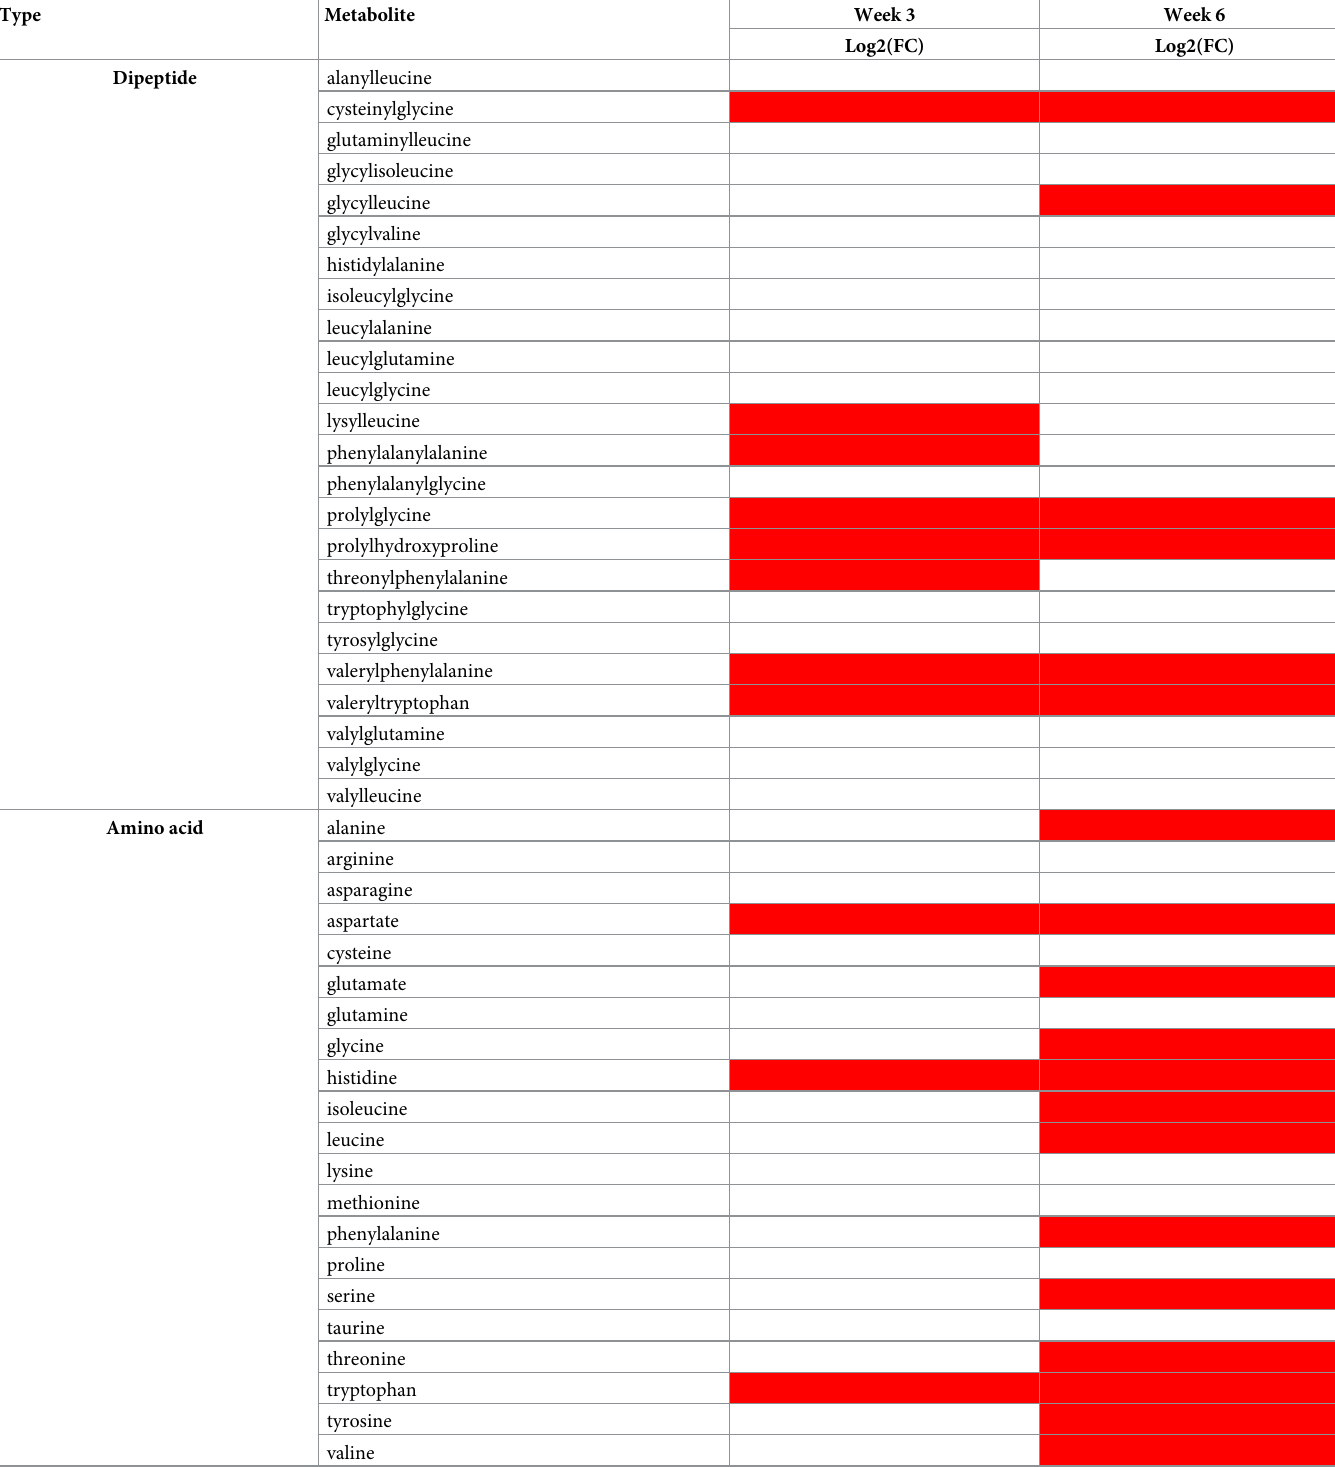
Table 5. Dipeptides and amino acids detected via metabolomic screening in fecal samples taken at weeks 3 and 6 from cats fed LRS or HRS